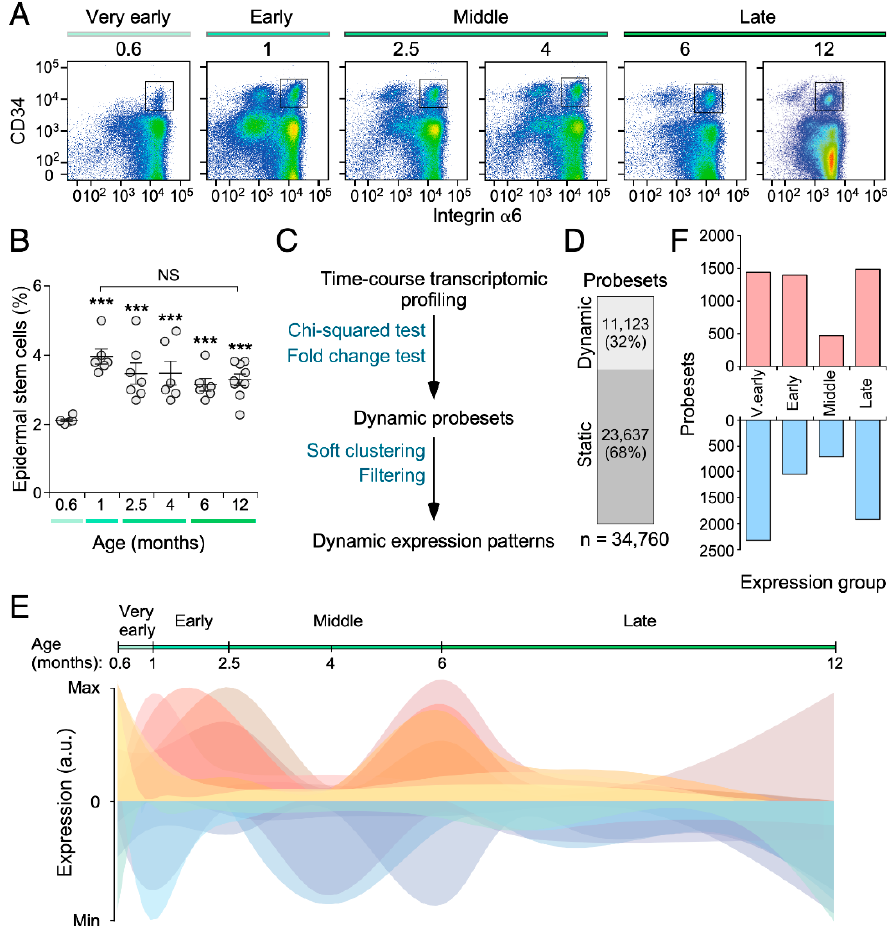
Figure 1. The transcriptome of skin stem cells fluctuates in an age-dependent manner. ( A ) Representative flow cytometry scatter plots showing the different epidermal populations according to CD34 and integrin α 6 expression at the indicated age points (top). The classification in “very early” (18-day-old), “early” (30-day-old), “middle” (2.5- to 4-month-old), and “late” (6- to 12-month-old) populations is also indicated (top). The gate used for the isolation of basal bulge epidermal stem cell population is depicted with a square. ( B ) Quantitation of the abundance of the CD34 + Itg α 6 + SSC pools in the skin of mice at the indicated ages. ***, p < 0.001; NS, not statistically significant (ANOVA and Dunnett’s tests, n = 6 (18-day-old mice), 6 (30-day-old mice), 7 (2.5-month-old mice), 6 (4-month-old mice), 6 (6-month-old mice), 9 (12-month-old mice). The correlation with the age intervals (“very early”, “early”, “middle”, “late”) is indicated with colored bars as in (A) (bottom). Data represent the mean ± SEM. ( C ) Scheme representing the bioinformatic pipeline followed to identify dynamic expression patterns of CD34 + Itg α 6 + SSCs. ( D ) Distribution of the 34,760 probesets of the Affymetrix Mouse Gene 1.0 ST array between the dynamic and static groups. ( E ) Graphical representation of the time-dependent fluctuation of the 14 nonredundant expression patterns of SSCs described in the main text. ( F ) Number of dynamic probesets found in the “very early” (V. early), “early”, “middle”, and “late” age time-points. Bar color indicates positively (red) and negatively (blue) expression enrichment of probesets against the baseline.